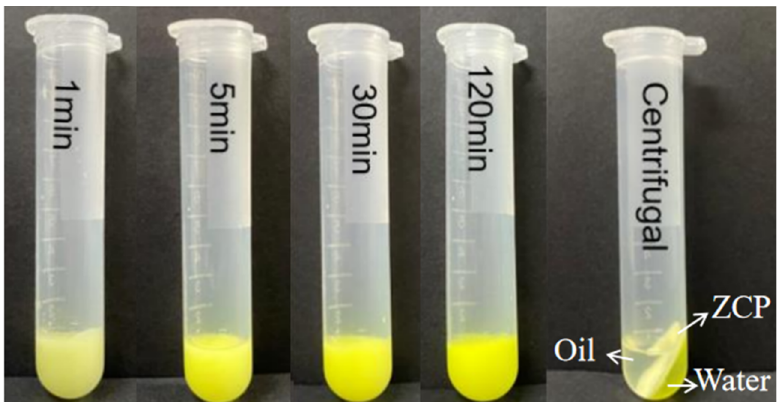
Figure 5. The degree of color development of p -NPP catalyzed reaction under different reaction times; after centrifugal demulsification, the water and oil phases.